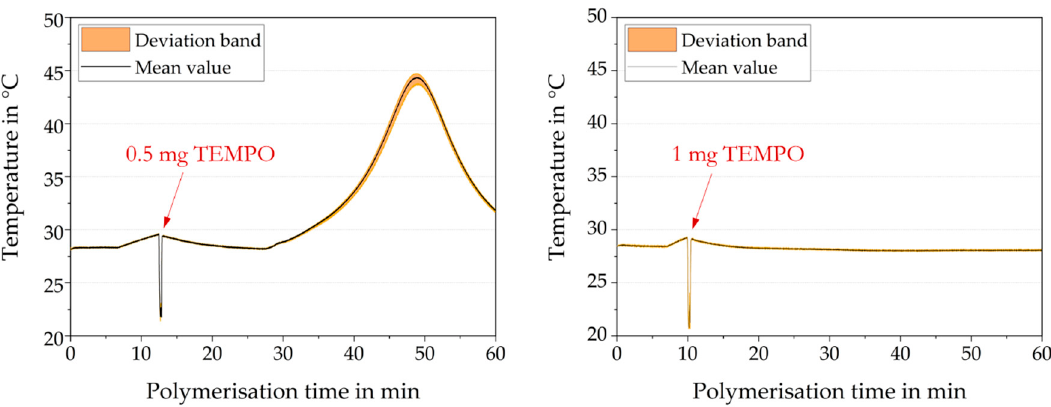
Figure 5. Temperature profiles of PBM redox polymerization using the TEMPO radical inhibitor at reported time.